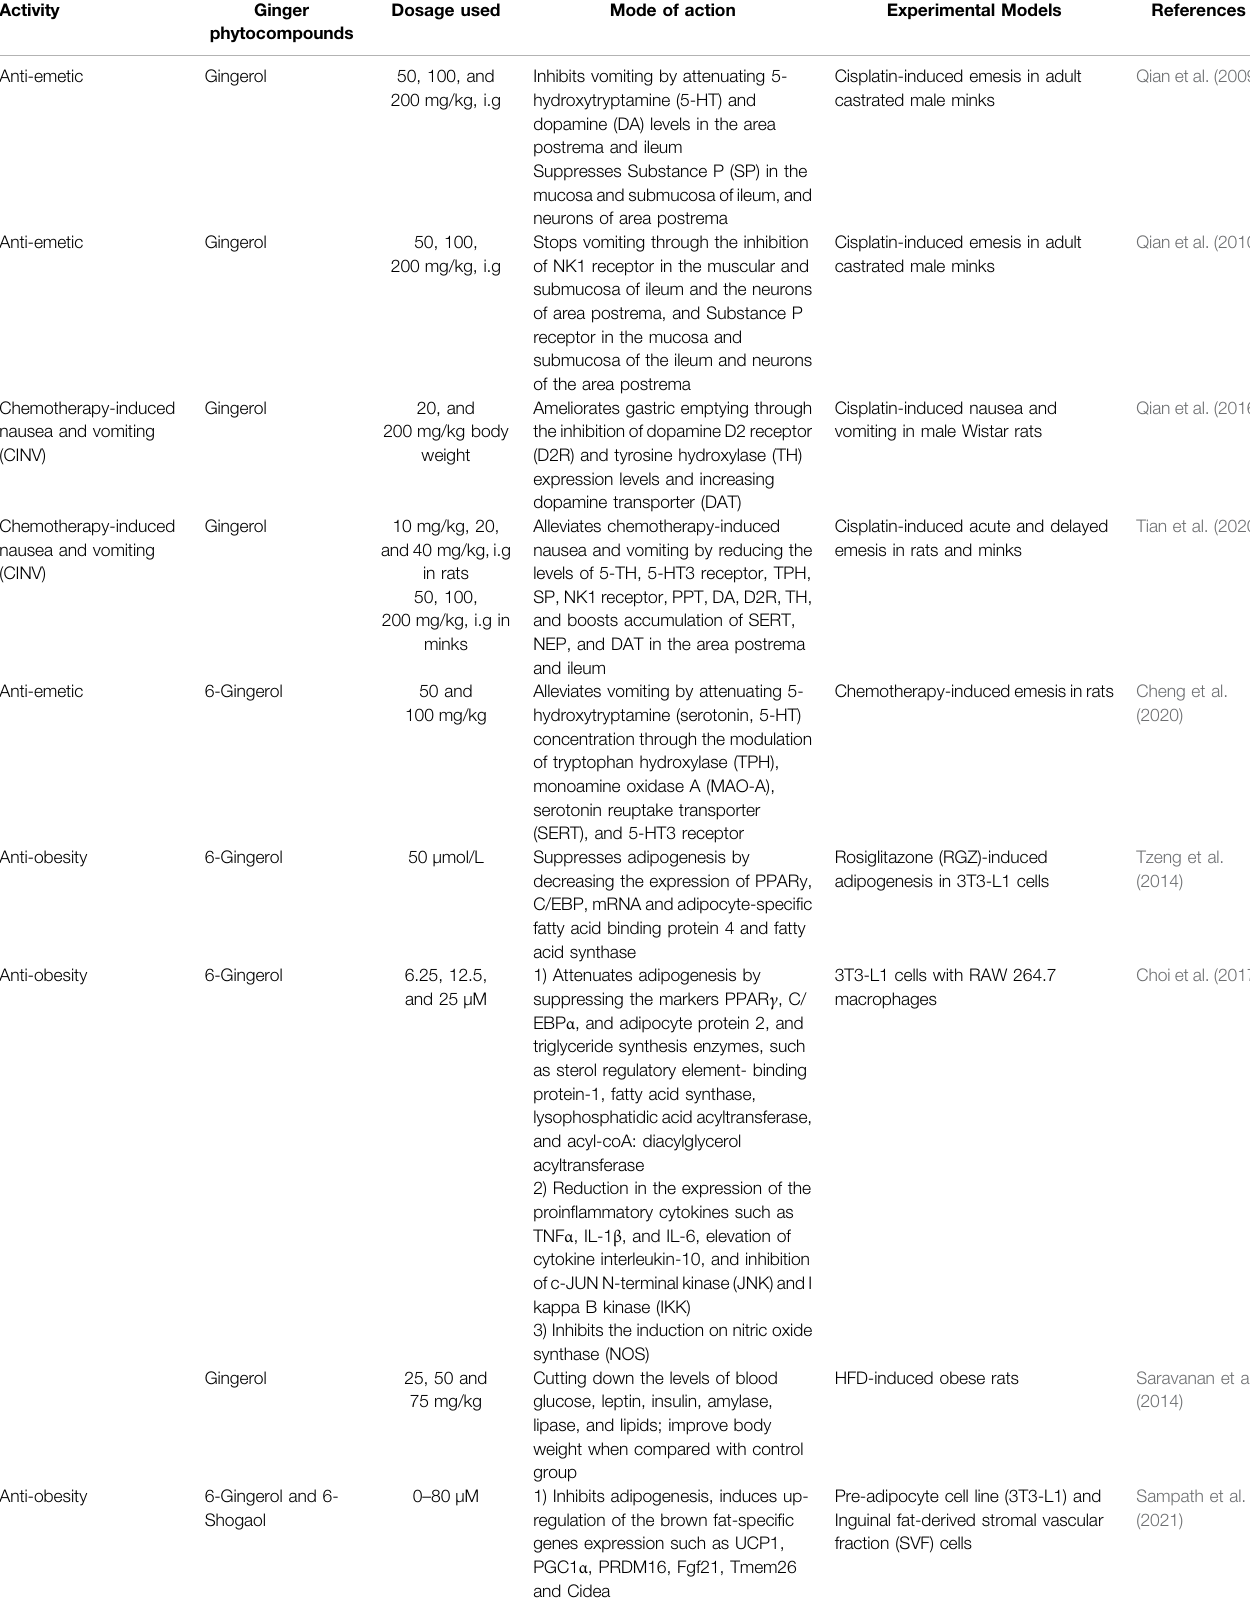
TABLE 3 | Pharmacological effects of ginger